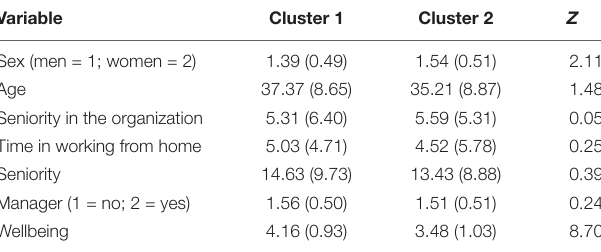
TABLE 3 | Test control variables between